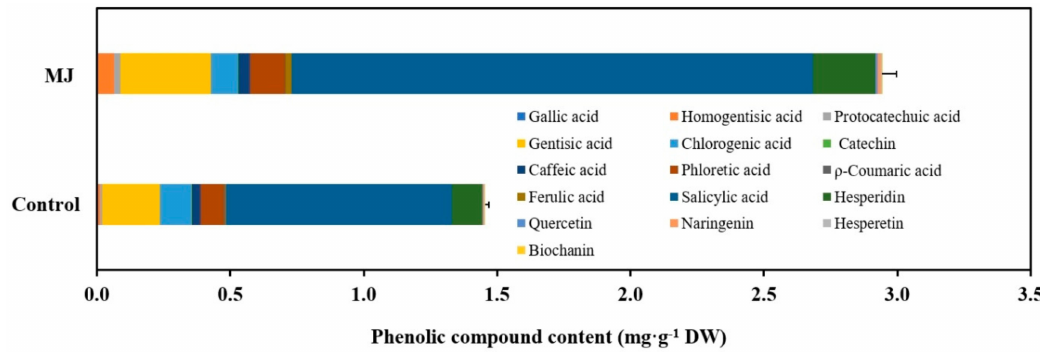
Figure 6. E ff ect of MJ on phenolic compounds production in Cnidium o ffi cinale adventitious root